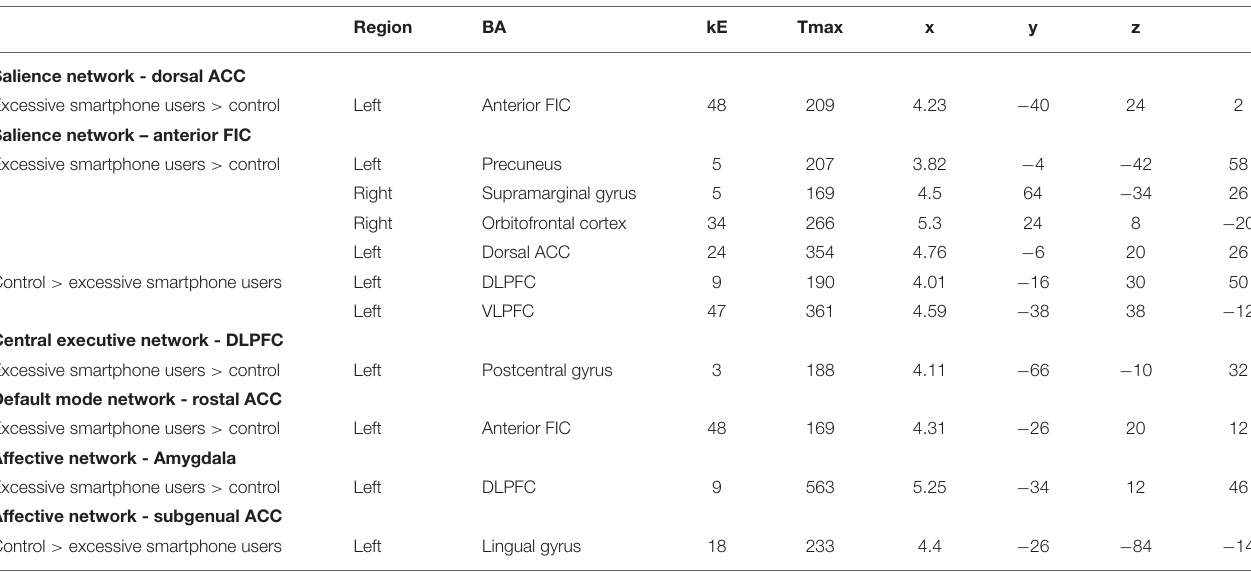
TABLE 2 | Whole-brain seed-based functional connectivity analysis results.